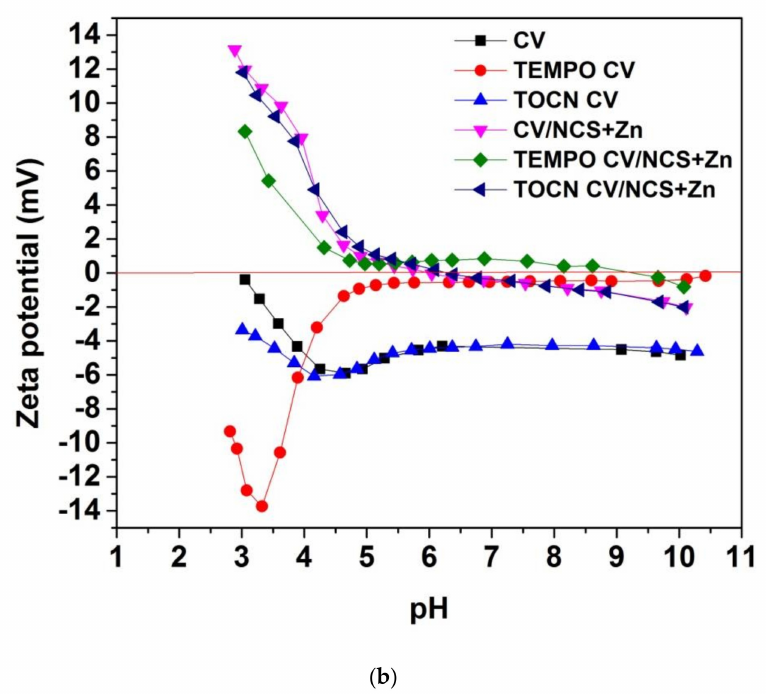
Figure 3. Zeta potential of ( a ) NCS and ( b ) NCS + Zn functionalized viscose fabrics, modified from